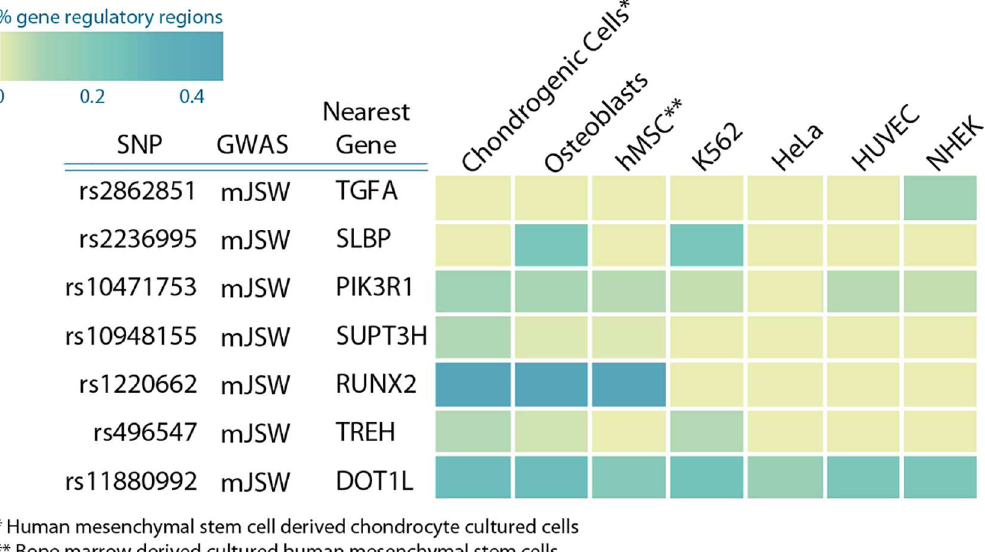
Fig 3. mJSW and OA associated variants are co-localized with potential gene regulatory markers. We examinedthe epigenetic histone marks in Chondrogenic cells, osteoblasts, hMSC, K562, HUVEC, HeLA and NHEK cells. This heatmap of the percentageof variants in gene regulatory regions (enhancer/promoter associated regions) in high LD (r 2 > 0.8) with lead GWAS SNP. Enrichment was calculated